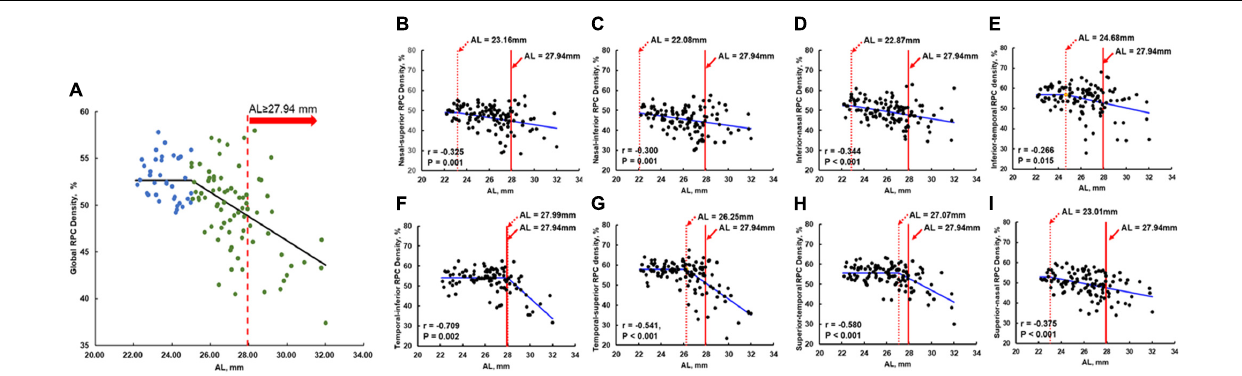
FIGURE 4 | Non-linear regression of the RPC density and the AL in global and all eight sectors. The solid red line in (A–I) was the AL cutoff (27.94 mm) for the visual impairment. The dashed red line in (B–I) indicates the RPC density flexion point along with the AL. To the left of the dashed red line, the RPC density was stable and not correlated with AL. To the right of the dashed red line, decreases in RPC density were significantly correlated with AL elongation (corresponding r and p -values were shown in the respective panels). To the right of the solid red line, the eyes were at high risk of visual impairment. (A) Non-linear regression of the global RPC density and the AL. (B) Nasal-superior RPC density vs. AL with AL flexion point as 23.16 mm. (C) Nasal-inferior RPC density vs. AL with AL flexion point as 22.08 mm. (D) Inferior-nasal RPC density vs. AL with AL flexion point as 22.87 mm. (E) Inferior-temporal RPC density vs. AL with AL flexion point as 24.68 mm. (F) Temporal-inferior RPC density vs. AL with AL flexion point as 27.99 mm. (G) Temporal-superior RPC density vs. AL with AL flexion point as 26.25 mm. (H) Superior-temporal RPC density vs. AL with AL flexion point as 27.07 mm. (I) Superior-nasal RPC density vs. AL with AL flexion point as 23.01 mm. RPC, radial peripapillary capillary; AL, axial